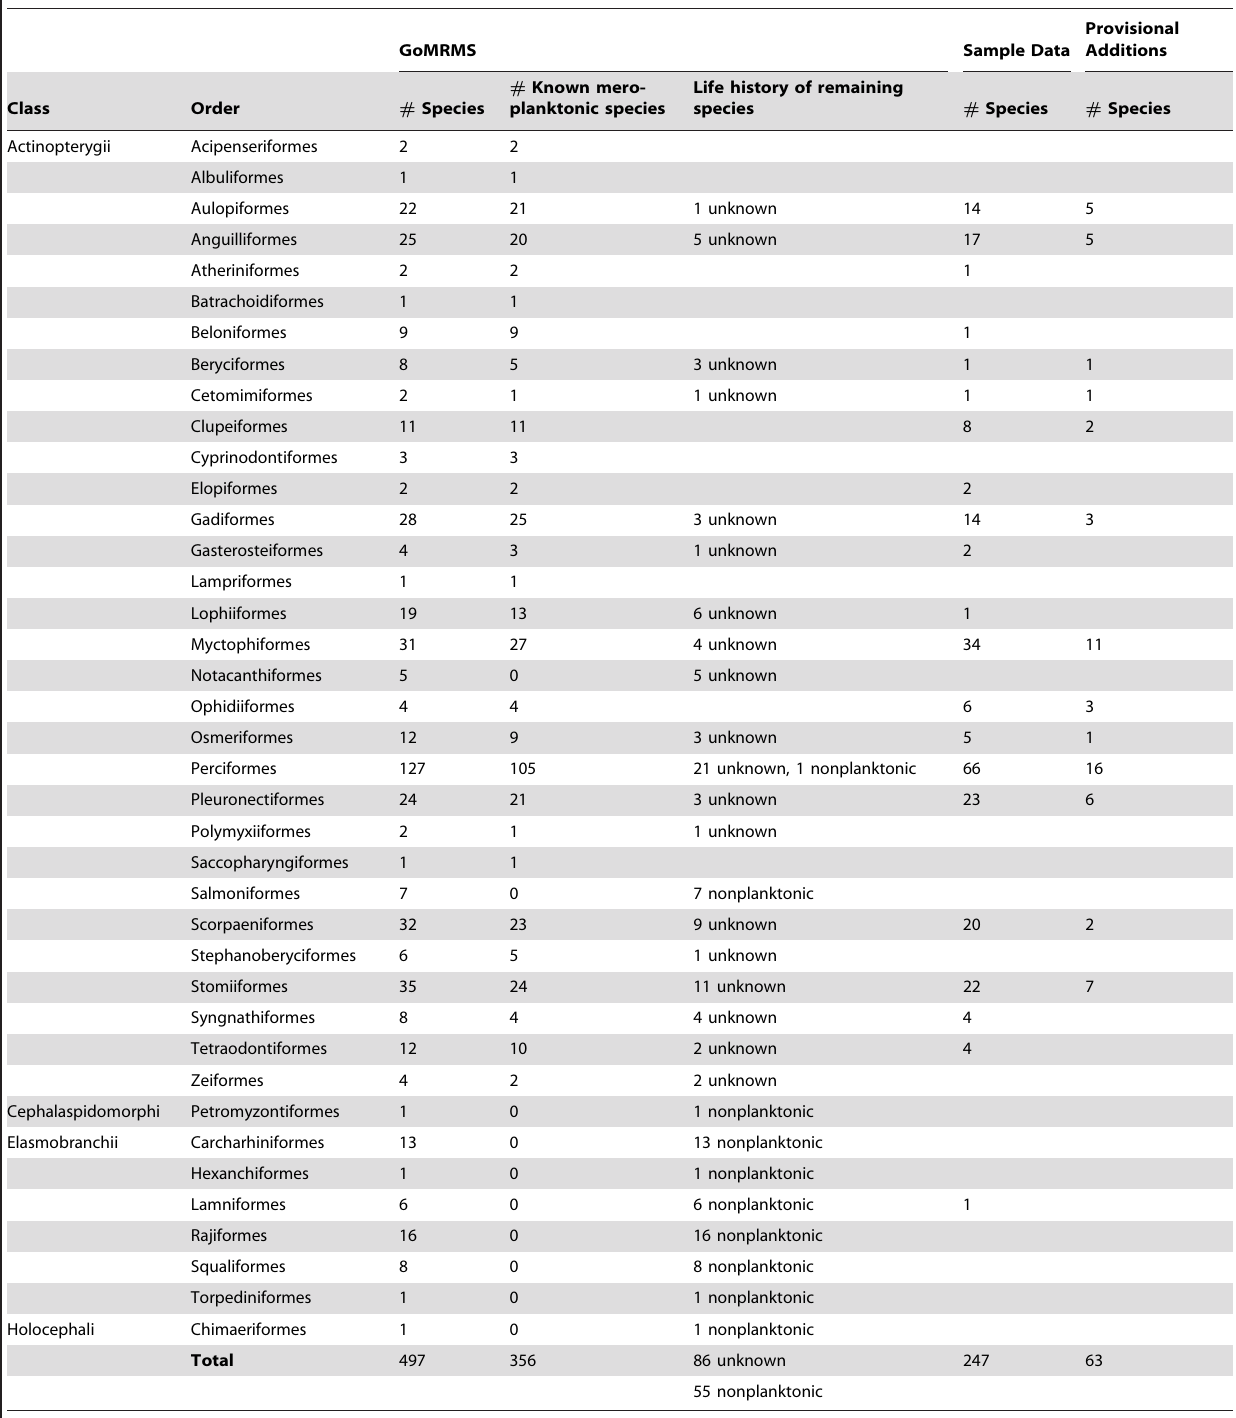
Table 1. Ichthyoplankton in the Gulf of Maine Area.